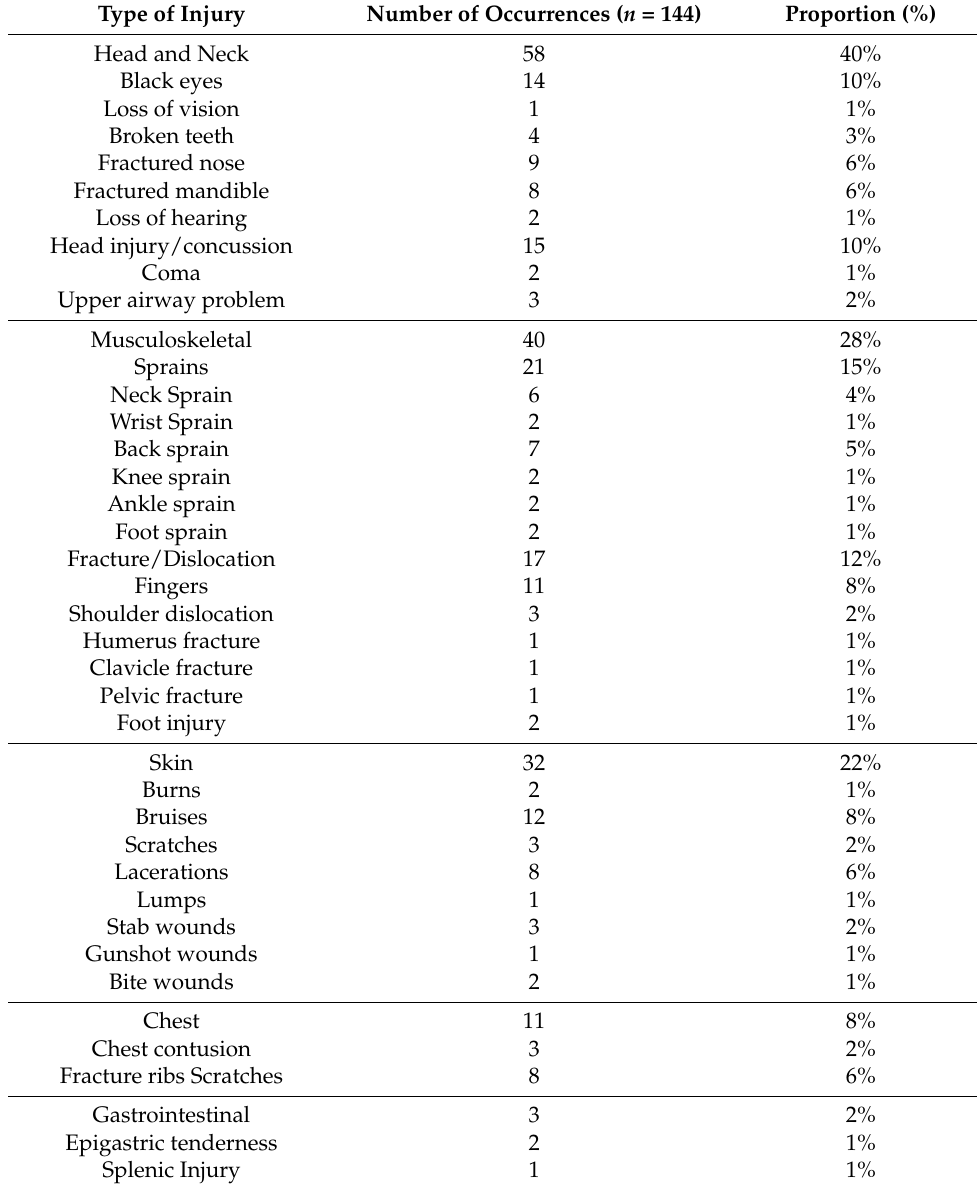
Table 2. Epidemiology of injuries related Intimate partner